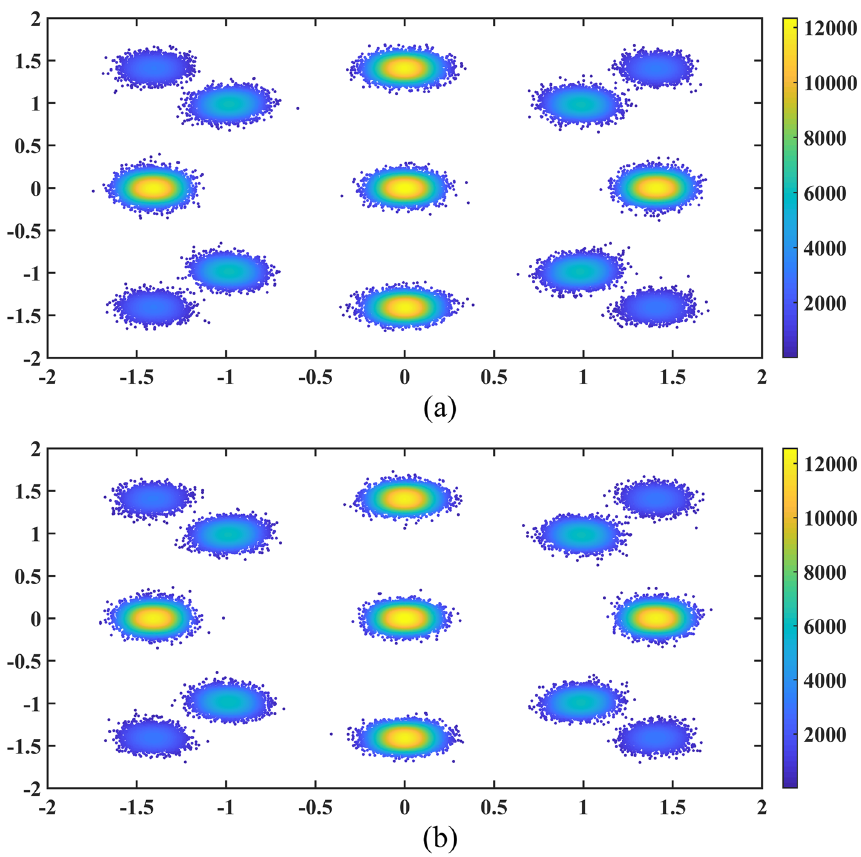
Fig. 5 The polarization states constellation diagram of a X -pol b Y -pol after running the compensation scheme (OSNR 30 dB)